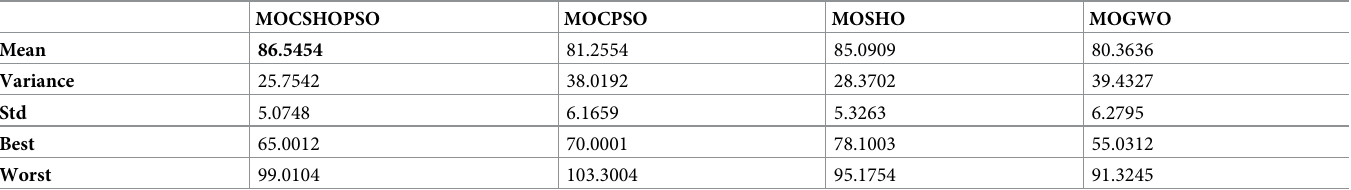
Table 5. Comparative analysis of different algorithms based on the maximum spread.